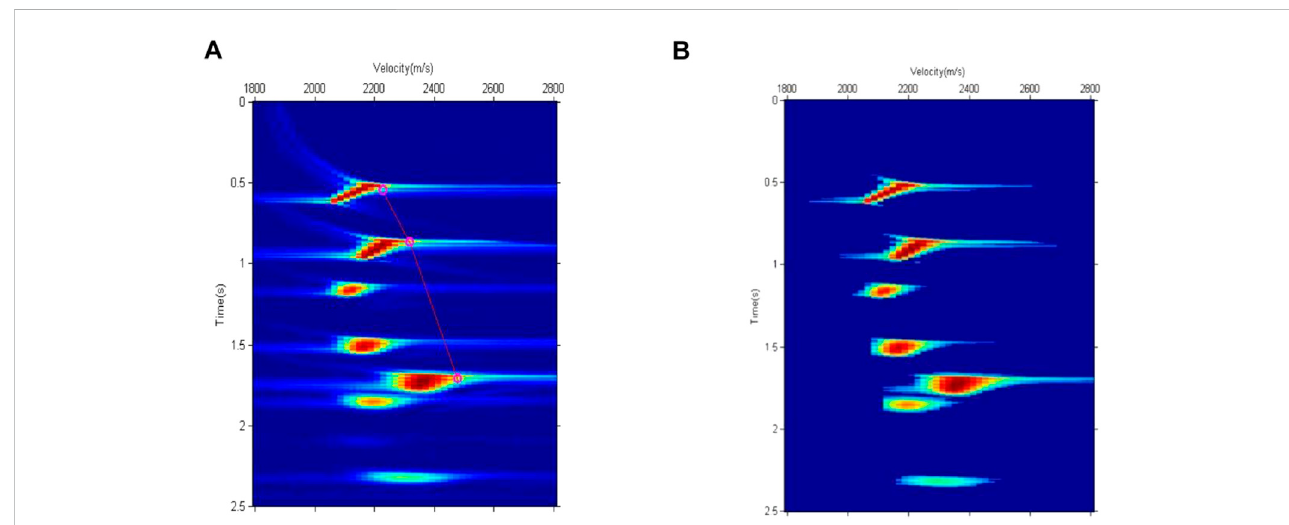
FIGURE 2 Semblance velocity spectrum and its calculation area. (A) Semblance velocity spectrum. (B) Calculation area of semblance velocity spectrum.